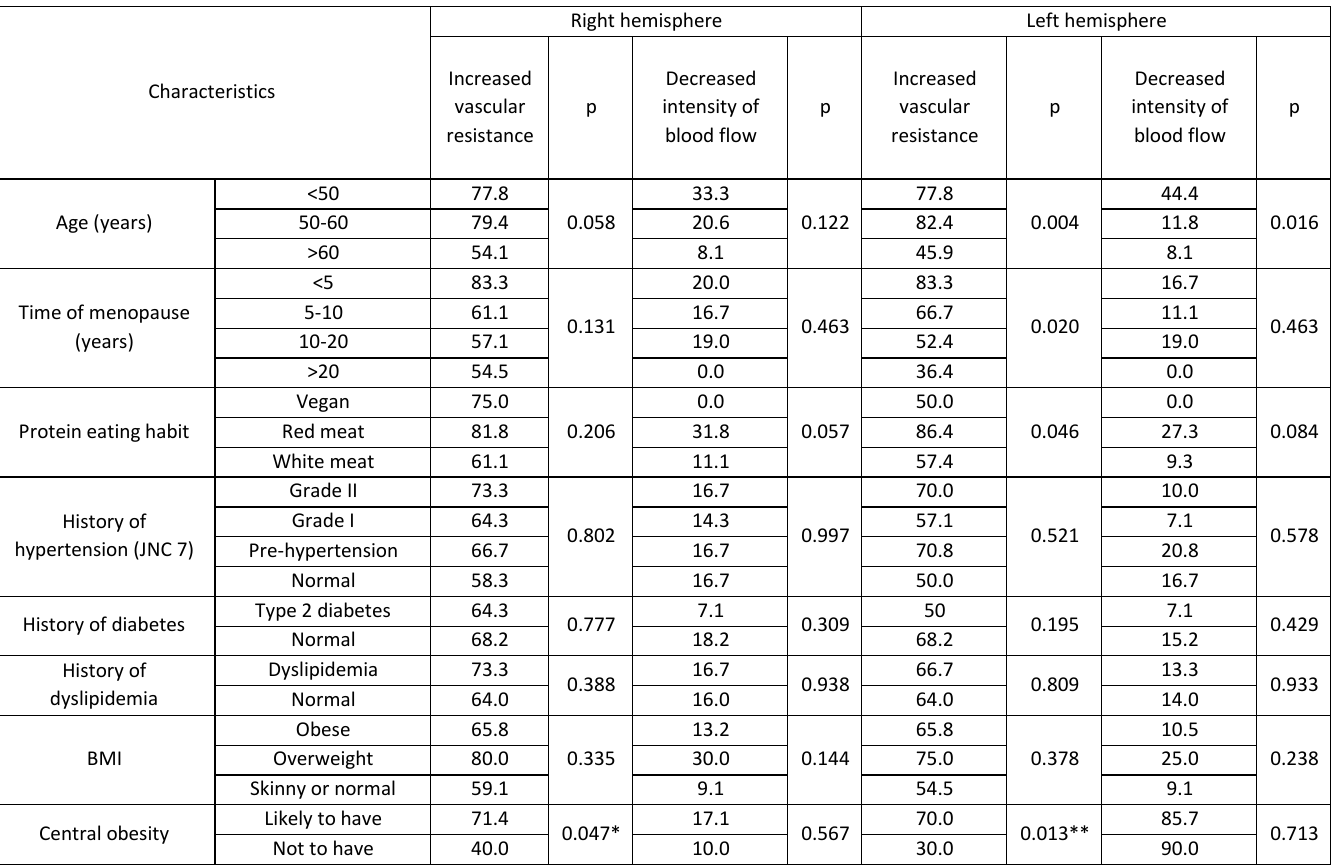
Table 3. Some factors related to abnormalities in REG